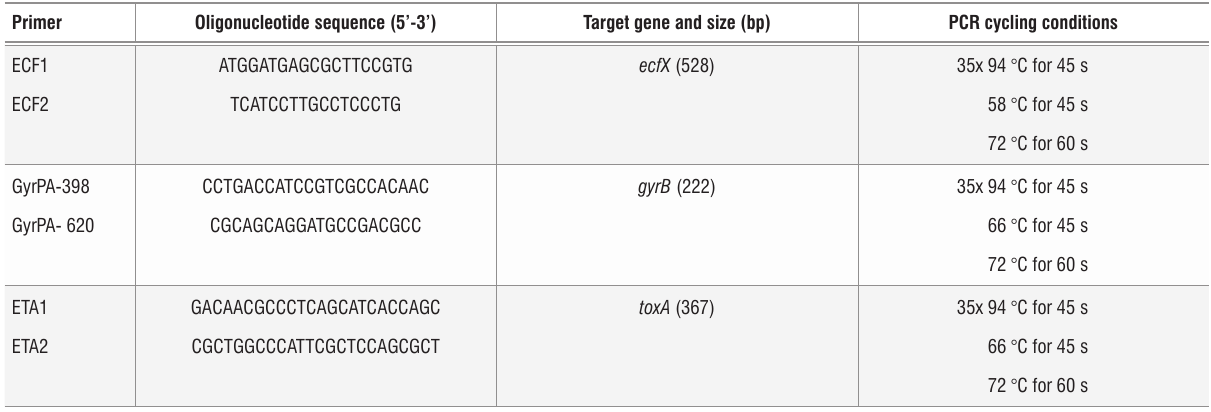
PCR, polymerase chain reaction: initial denaturing step of 95 °C for 5 min and final strand extension of 72 °C for 5